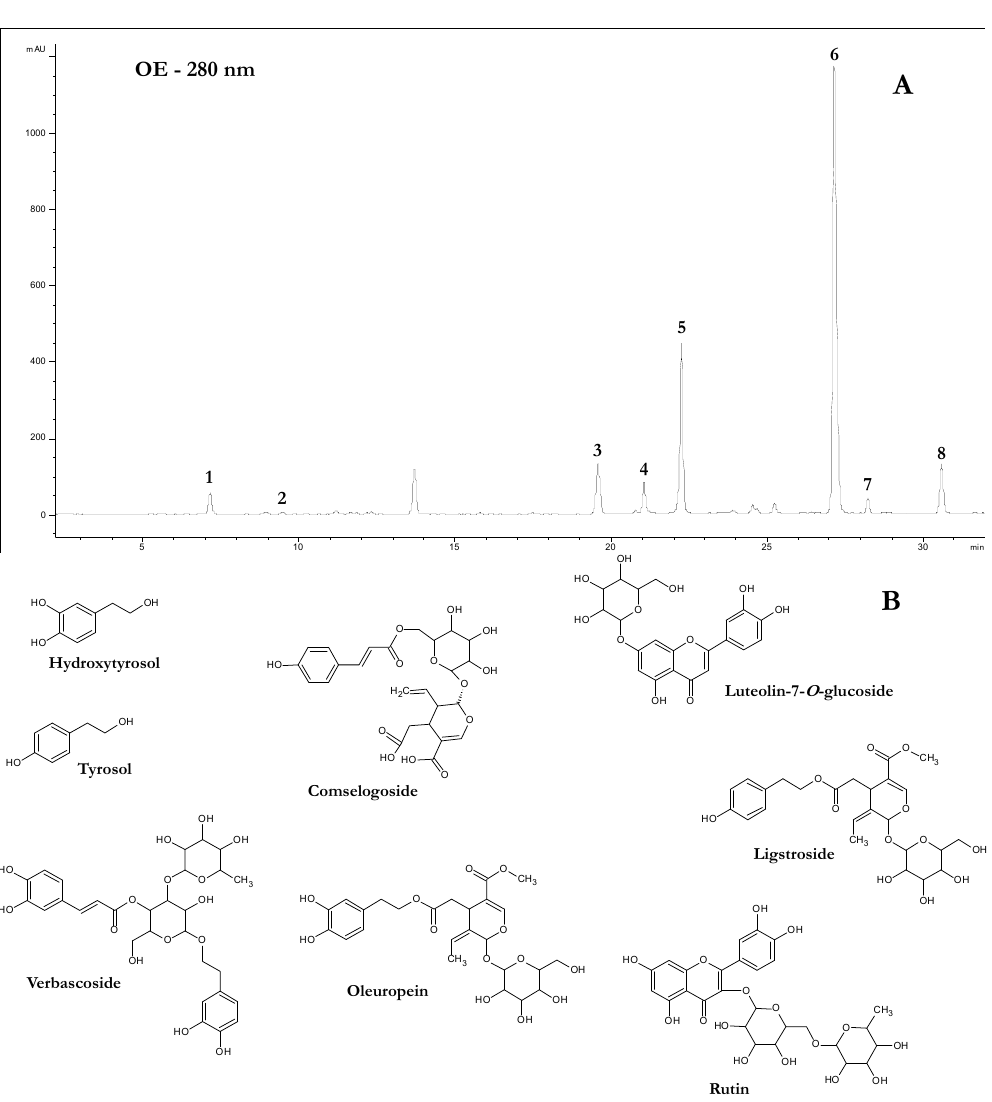
Figure 1. ( A ) Phenolic profile at 280 nm of the olive extract (OE). 1, hydroxytyrosol; 2, tyrosol; 3, rutin; 4, luteolin-7-O-glucoside; 5, verbascoside; 6, oleuropein; 7, comselogoside; 8, ligstroside. ( B ) The main phenolic compounds detected in the olive extract.